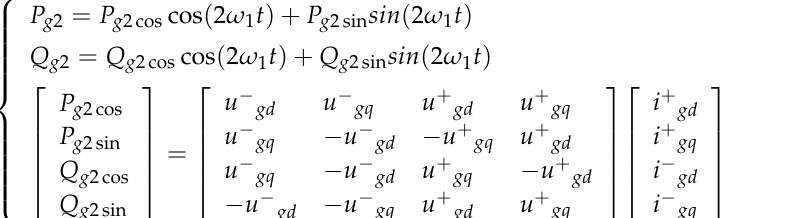
Q represent the double- and 2 g u + represent the d -axis and q -axis and gq u − and u − represent the d -axis and gd gq i + and i + represent the d - gd gq i − and i − represent gd gq